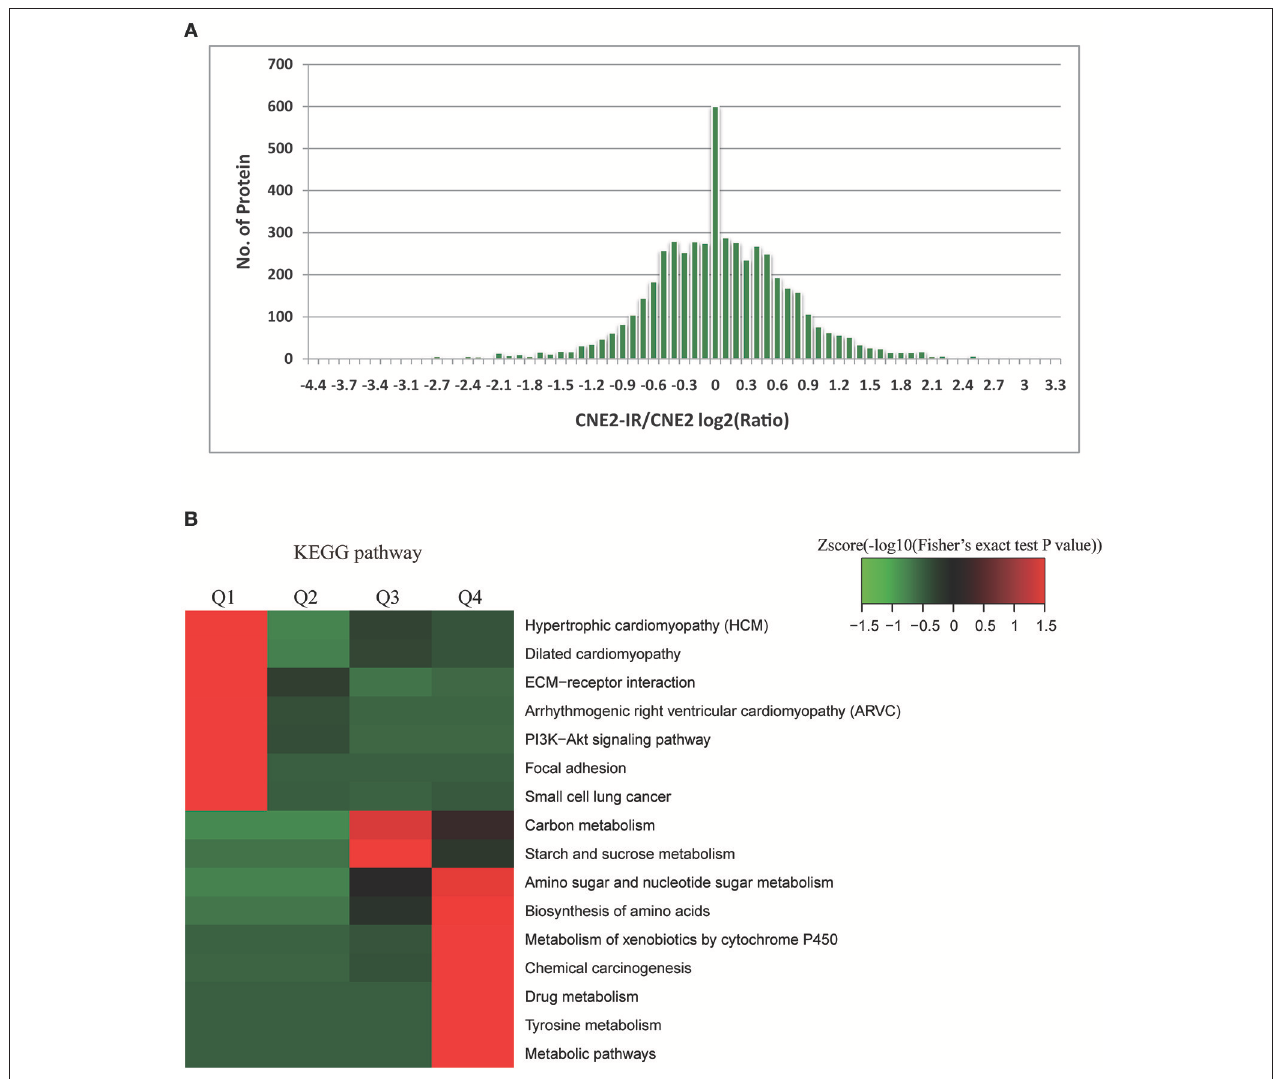
FIGURE 2 | Bioinformatics analysis on radiosensitivity-related proteome in CNE2 and CNE2-IR. (A) Enrichment of differentially expressed proteins in CNE2 and CNE2-IR. Among the 754 differentially expressed proteins, 440 proteins were with increased level (CNE2-IR/CNE2, fold change ≥ 2) and 314 with decreased level (CNE2-IR/CNE2, fold change ≤ 0.5). (B) Intensive bioinformatic analysis on 754 differentially expressed proteins based on KEGG pathway analysis. The quantifiable proteins in this study were divided into four quantitative categories according to the CNE2-IR/CNE2 Ratio: Q1 (CNE2-IR/CNE2 Ratio < 0.33 and P -value < 0.05), Q2 (0.33 < CNE2-IR/CNE2 Ratio < 0.5 and P -value < 0.05), Q3 (2 < CNE2-IR/CNE2 Ratio < 3 and P -value < 0.05) and Q4 (CNE2-IR/CNE2 Ratio > 3 and P -value <